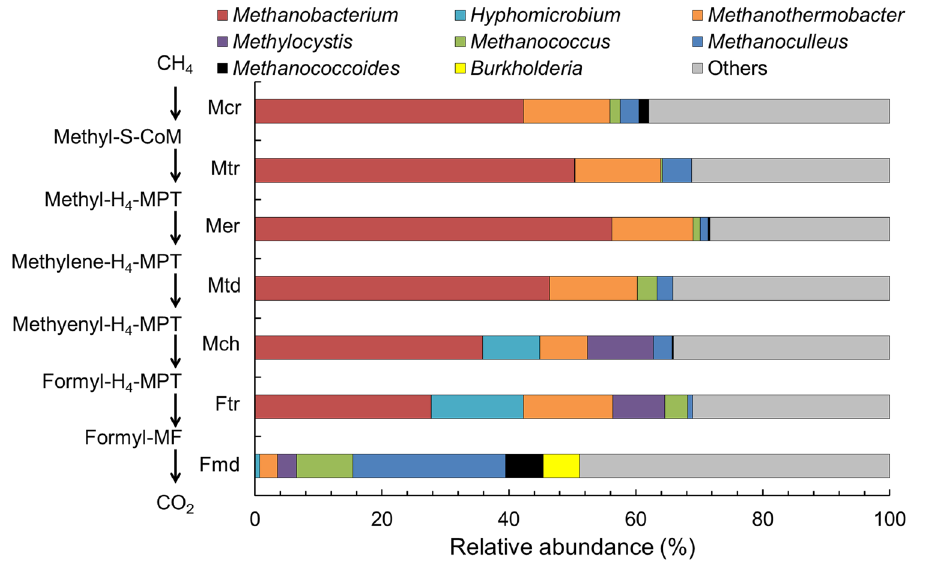
Figure 3. Relative abundances of genes for AOM-related enzymes according to taxonomic annotations by BLAST. The category “Others” indicates genera with relative abundance below